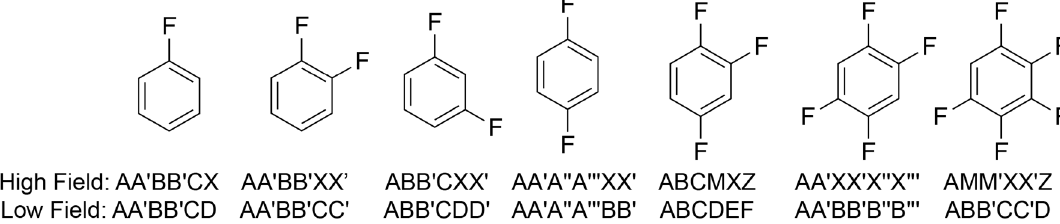
Figure 8. The Pople notation for the fluorobenzene compounds studied here. For each compound, there are two di ff erent Pople notations—the top is the traditional Pople notation for a high field spectrum in the strong homonuclear J -coupling limit, while the bottom notation is the Pople notation for the same system at LF, in the strong heteronuclear J -coupling limit. Note that at LF, the Larmor frequency di ff erence was such that none of the nuclei were well separated and must all be considered as a single system.